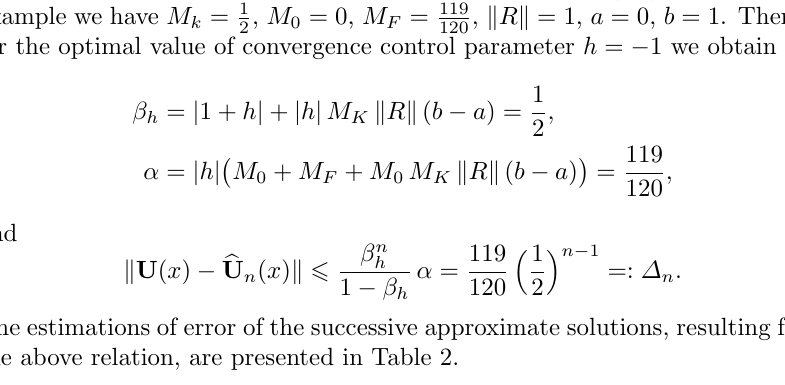
much lower than its estimation resulting from inequality (2.9). In considered